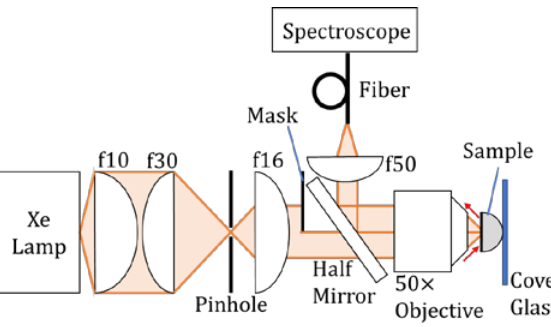
Figure 2. Optical system for microscopic reflection spectroscopy. The sample was irradiated from either the equatorial-plane or the spherical side.